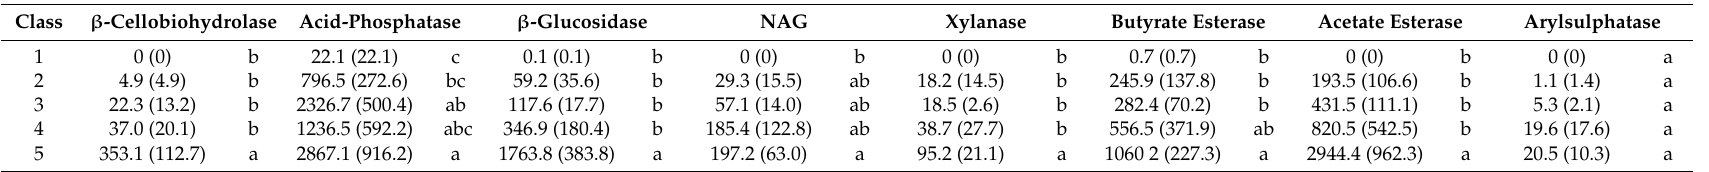
Table 5. Average values of enzymatic activities (nmol MUF g − 1 · h − 1 ) measured in black pine deadwood samples from the different decay classes; standard errors in